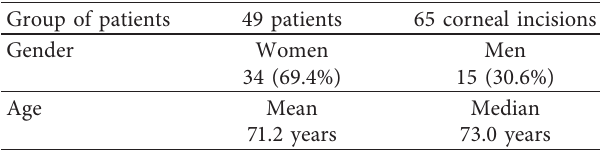
Table 1: Patients group characteristics.